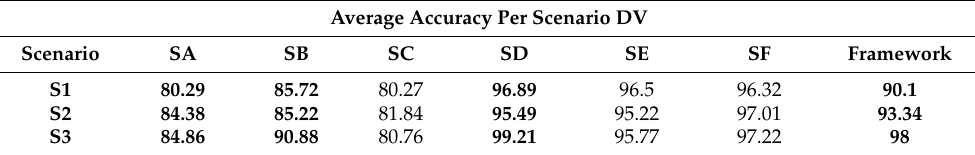
Table 14. Average accuracy per scenario DV.